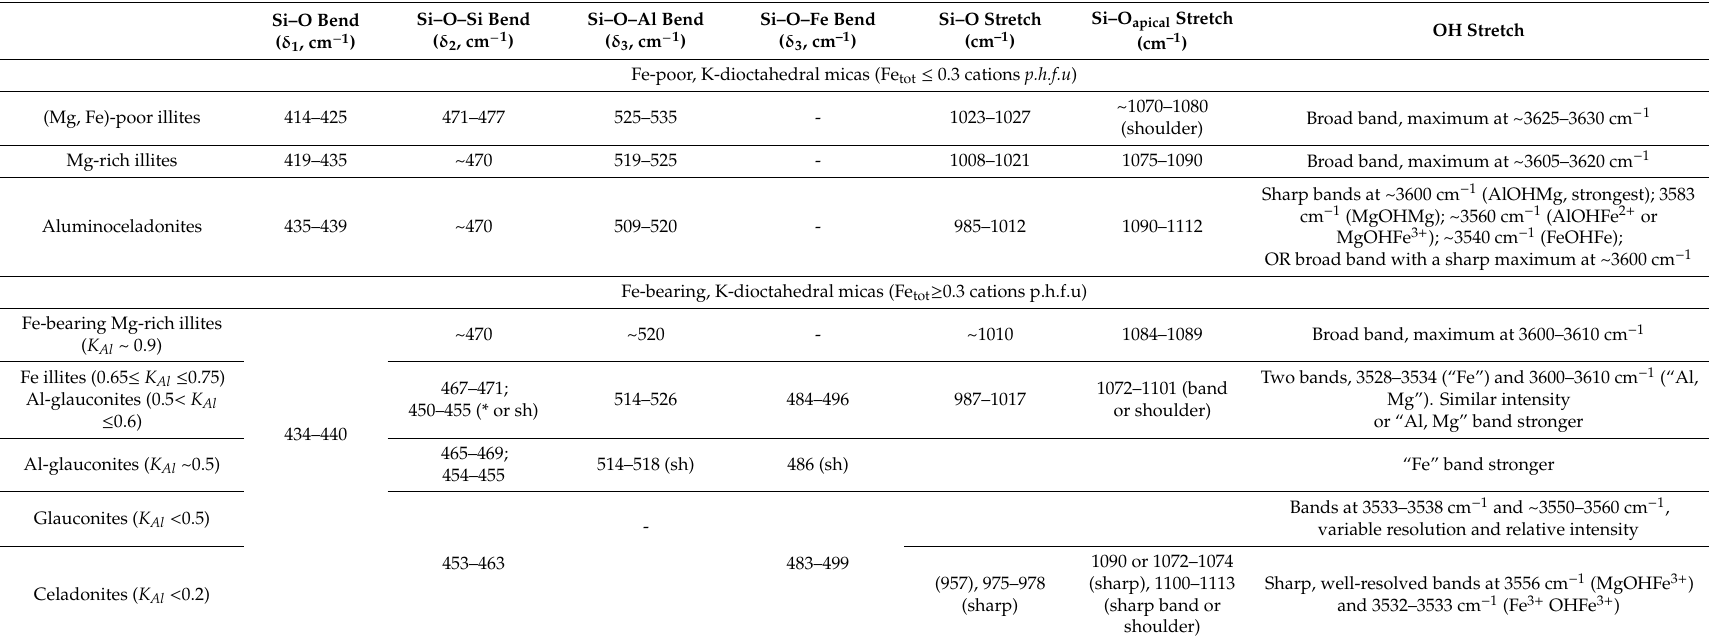
Table 7. FTIR distinctive features for K-dioctahedral 1 M micas (see text for details and